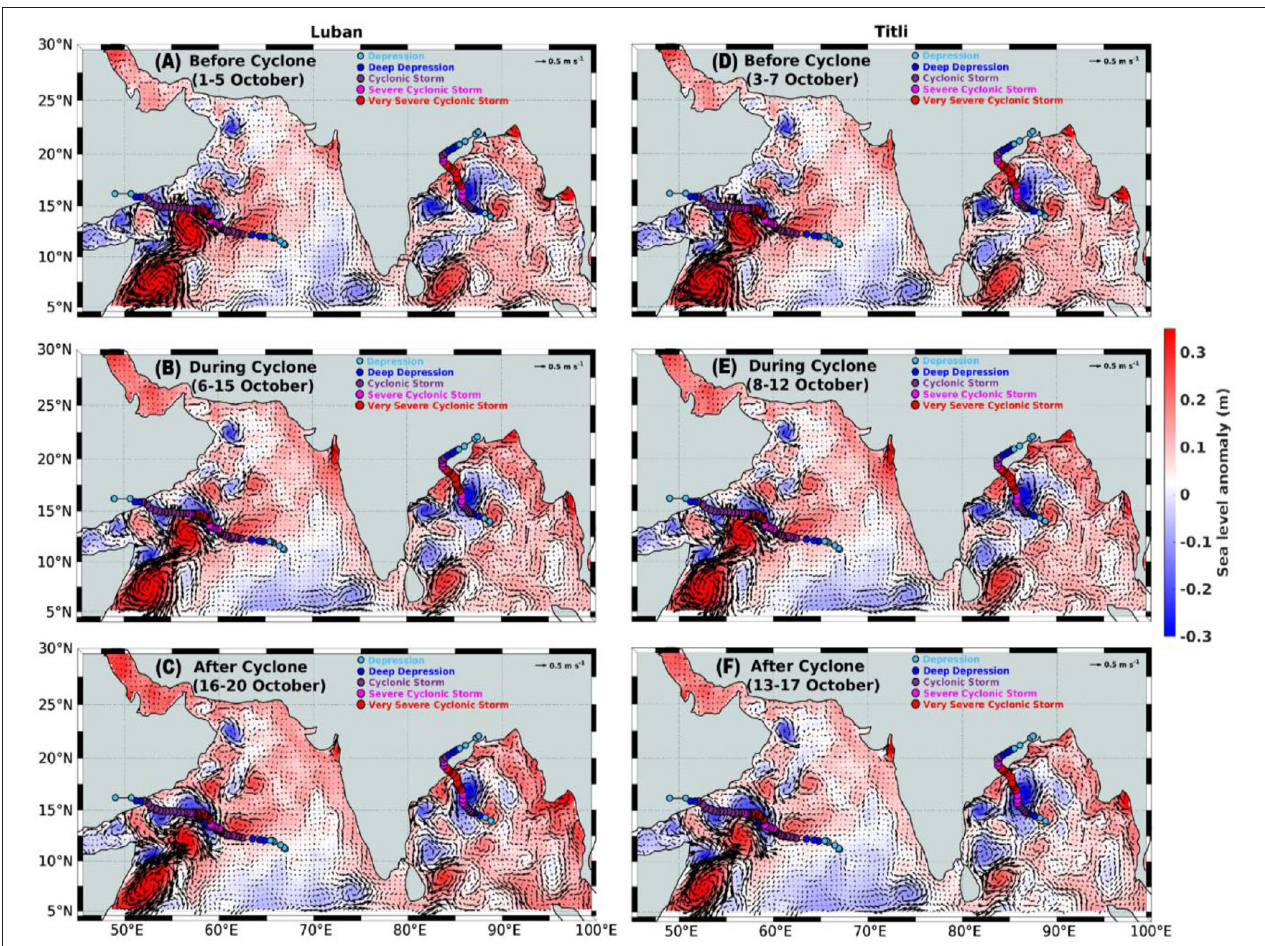
FIGURE 4 | A spatial map of sea level anomaly (m) overlaid with the geostrophic current (m/s) before (A,D) , during (B,E) , and after (C,F) cyclones Luban (A–C) and Titli (D–F) , superposed with cyclone tracks.